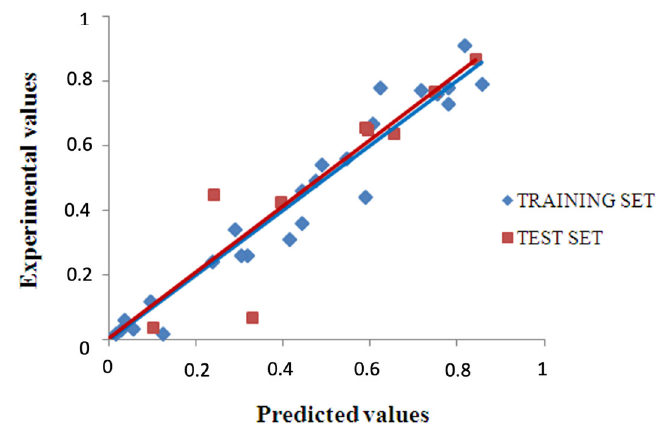
Figure 3. Correlation plot of the experimental inhibition values versus predicted ones for the 3D-QSAR CoMFA model. Table 3. Enalos Model Acceptability Criteria KNIME node screenshots for the CoMFA model.